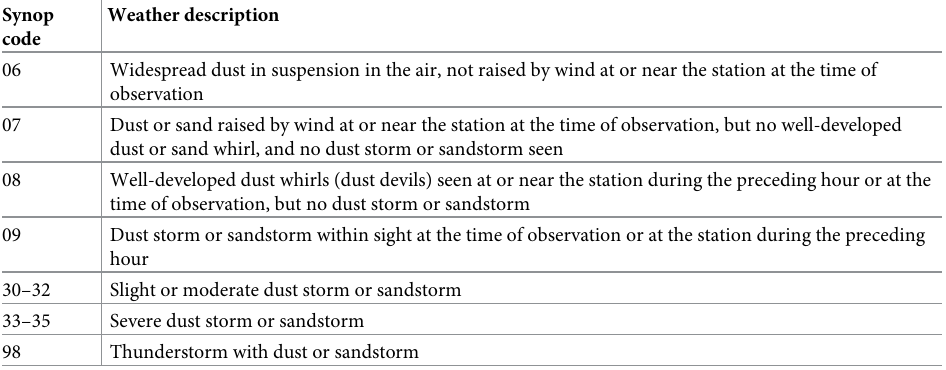
Table 1. Phenomena related to sand and dust storms based on the WMO weather state codes. Synop